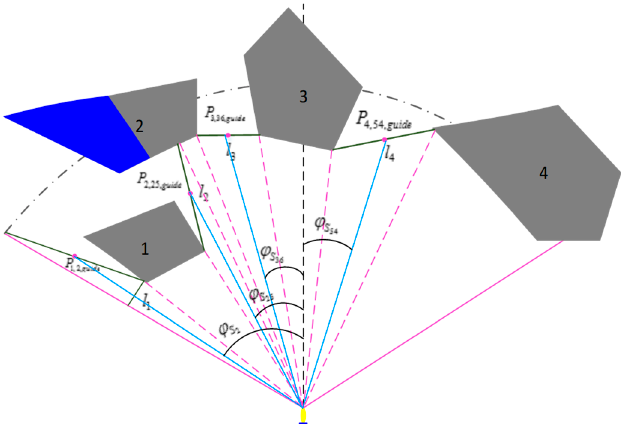
Figure 12. Dense obstacles environment avoidance.